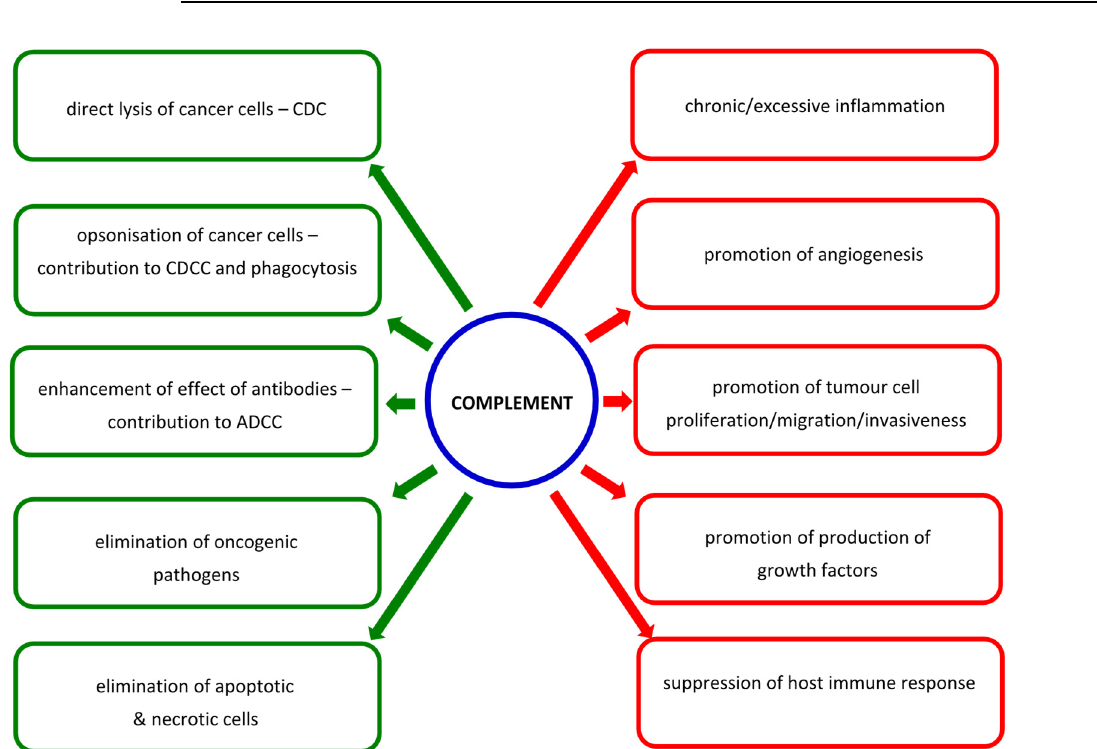
Figure 2. Multifaceted associations of complement with cancer. ( Left panel )—effects beneficial for the host: complement activation leads to direct lysis of cancer cells (via formation of C5b9 complex; complement-dependent cytotoxicity, CDC), contributes to complement-dependent cellular cytotoxicity (CDCC) and phagocytosis (via opsonization of cancer cells with activated compounds), enhances the effect of antibodies (including therapeutic) (contribution to antibody-dependent